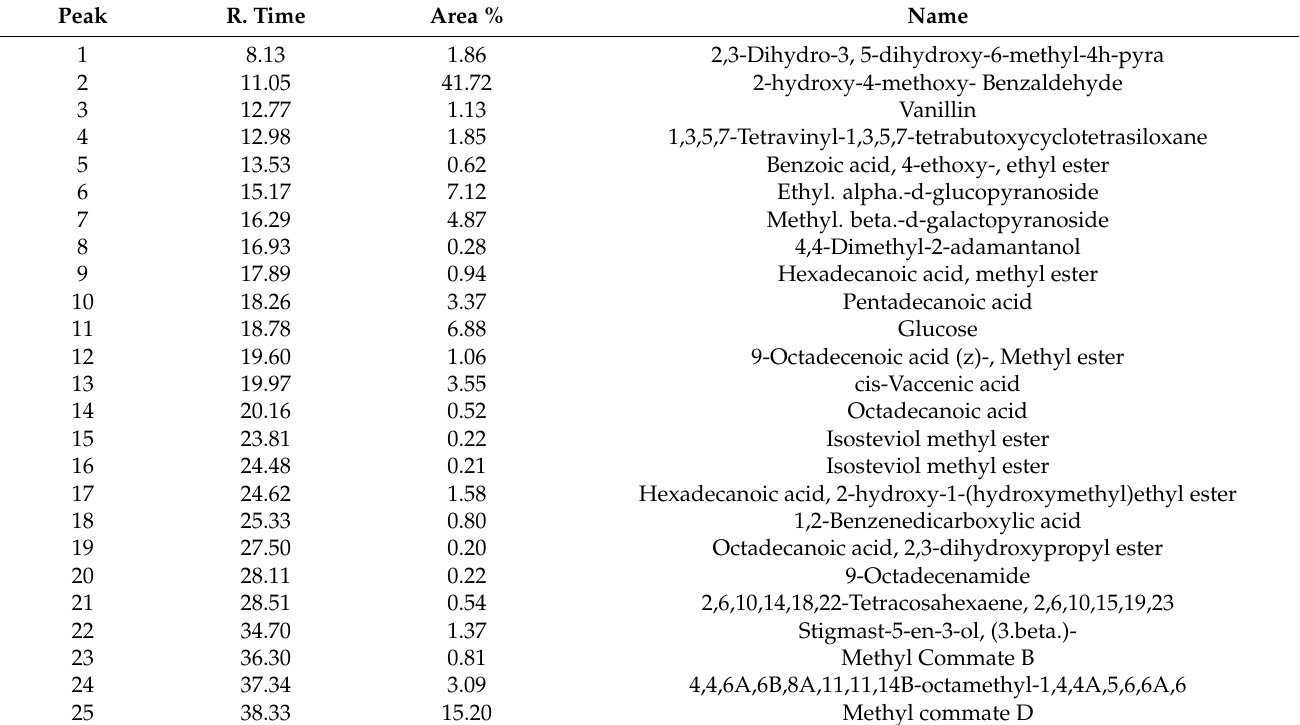
Table 1. GC-MS analysis of methanolic root extract of D. hamiltonii